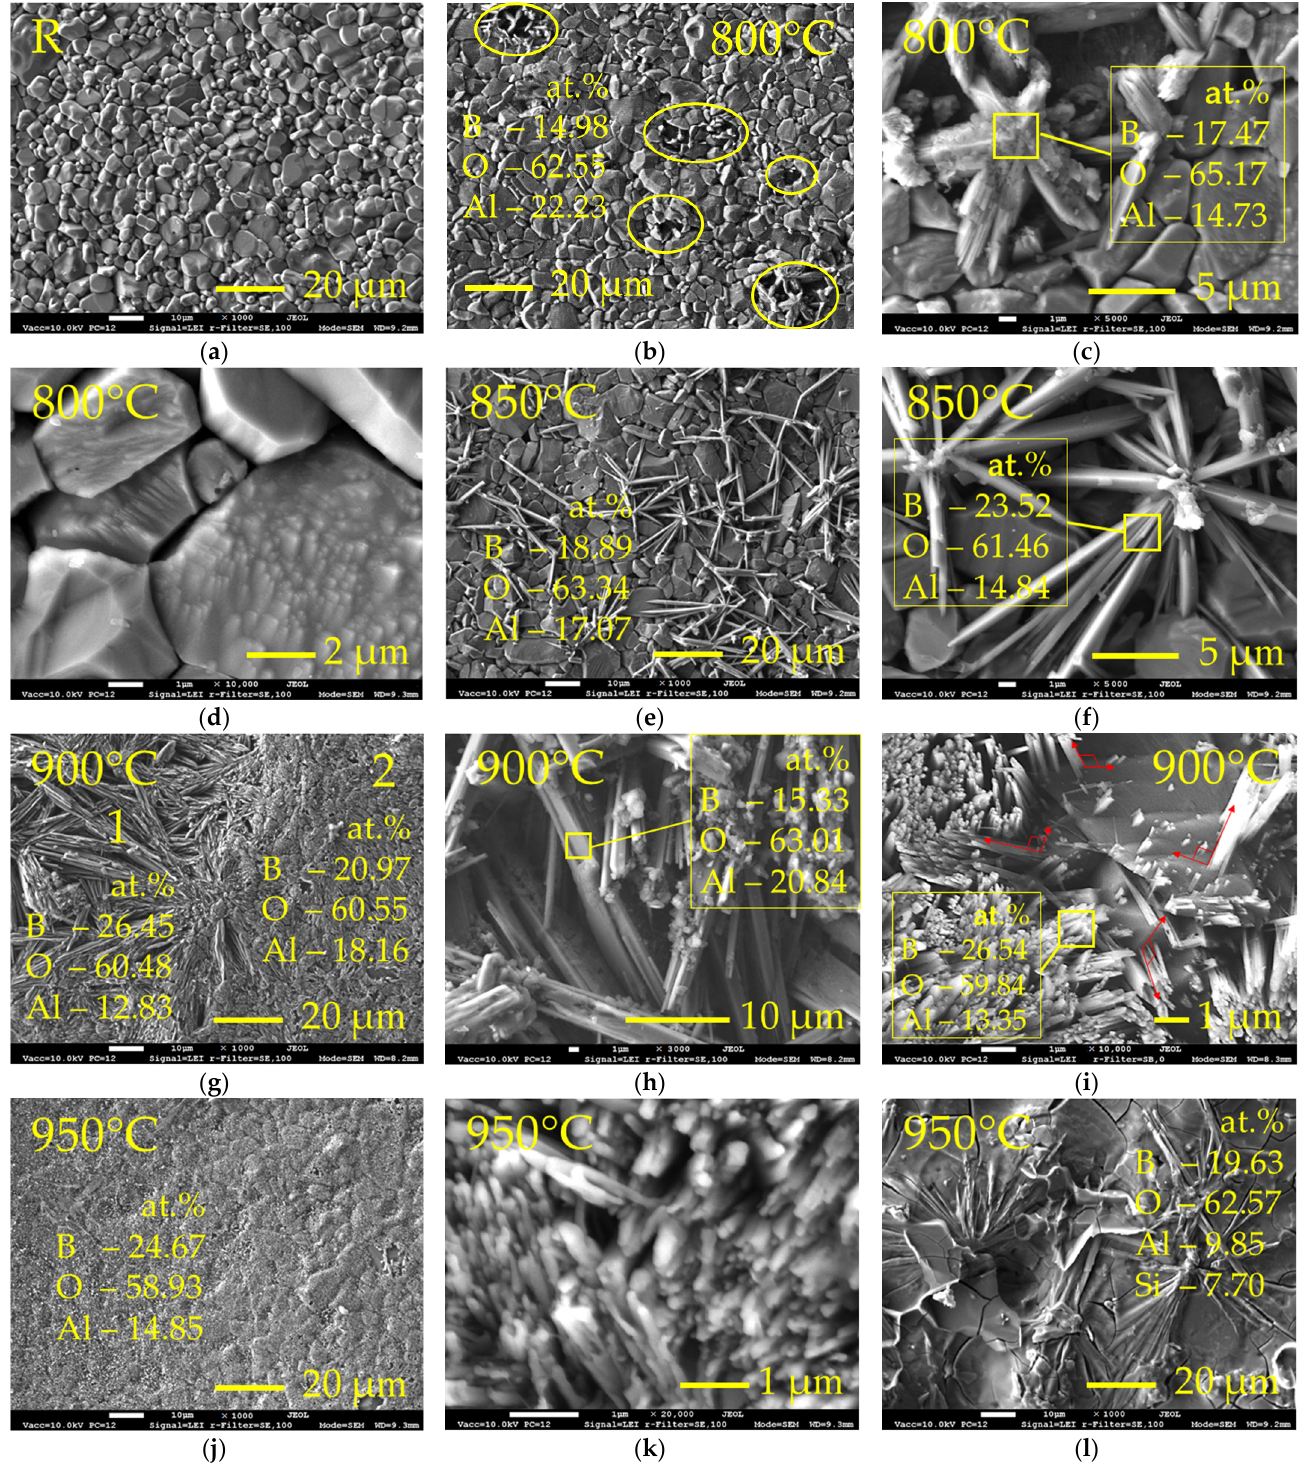
Figure 1. SEM micrographs of the reference Al 2 O 3 sample surface ( a ) and surfaces of Al 2 O 3 samples after boronizing at 800 ◦ C ( b – d ), 850 ◦ C ( e , f ), 900 ◦ C ( g – i ) and 950 ◦ C ( j – l ) temperatures; ( b ) yellow ovals show points of the appearance of aluminium borate crystals on surface; in images, the concentration of major elements is given (the remaining are Ca, Mg, Si); R—reference sample.